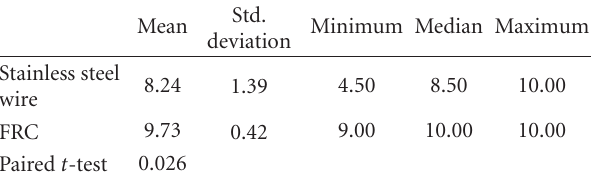
Table 2: Descriptive statistics of VAS values.